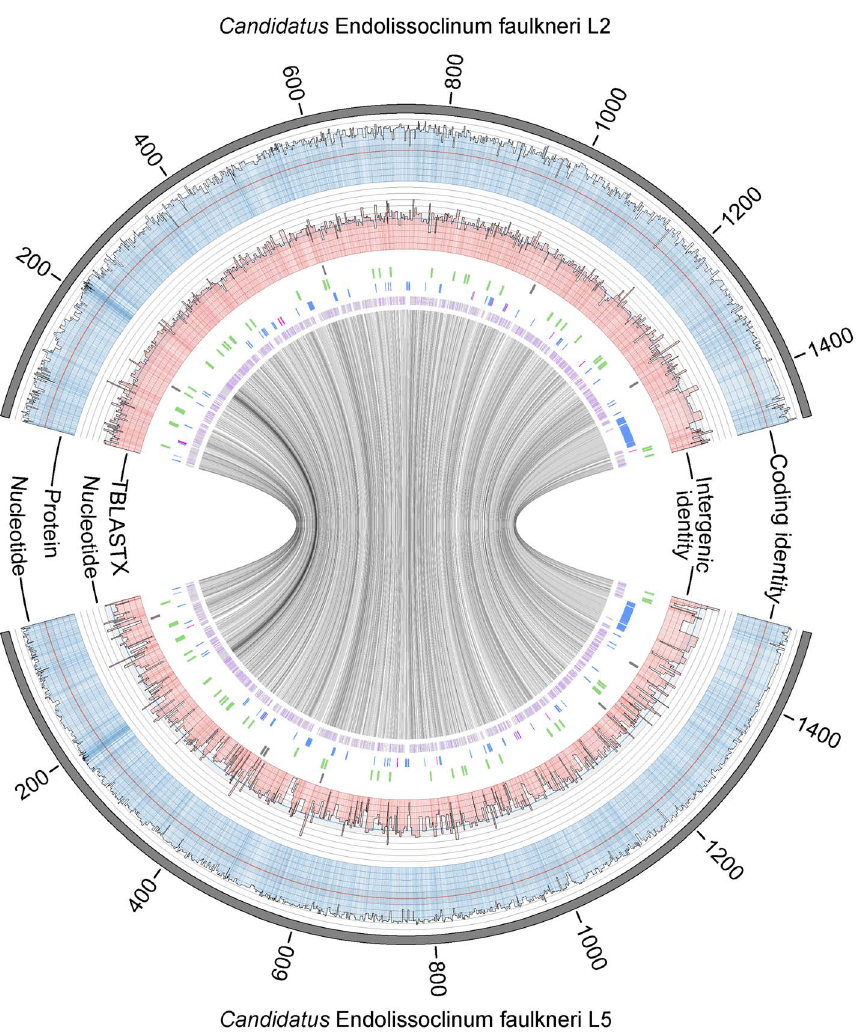
Figure 3. Comparative map of the genomes of Ca. E. faulkneri L2 (top) and L5 (bottom). Outer line graphs show protein and nucleotide identities for corresponding coding and noncoding regions (as indicated). In each case the scale runs outwards from 0–100% with lines at intervals of 10%. The 50% line is shown in a contrasting color (red or blue, as appropriate). Note: These graphs are reciprocal and interchangeable, and are plotted against either L2 or L5 for clarity. Immediately inside line graphs are shown the positions of pseudogenes (grey), RNA genes (green), genes that do not have homologs in BAL199, but are shared by both Ca. E. faulkneri strains (blue, this category includes all ptz genes), and genes that do not have homologs in BAL199, and are unique to one Ca. E. faulkneri strain (magenta). The remaining genes (i.e. genes that have a homolog in BAL199), are shown in the innermost track. Note: positioning of the gene categories on different tracks are to allow effective visualization of some positions that overlap due to the pxiel width in the figure. The inner circle shows links between homologous protein coding genes in the two strains of Ca. E. faulkneri.